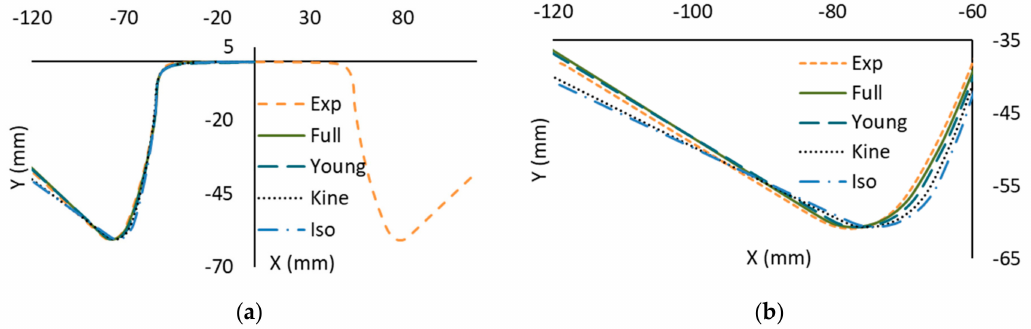
Figure 13. Springback prediction of the di ff erent models for the AR H-BHF case. ( a ) Whole profile and ( b ) left side of the profile.